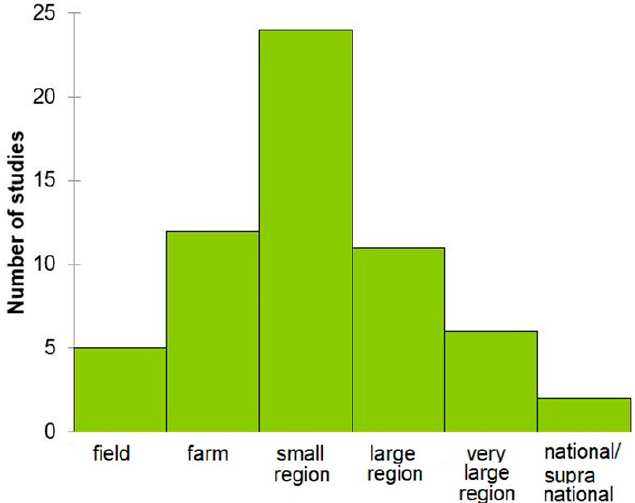
Figure 4. Histogram of study scales considered in satellite-derived SOC studies.